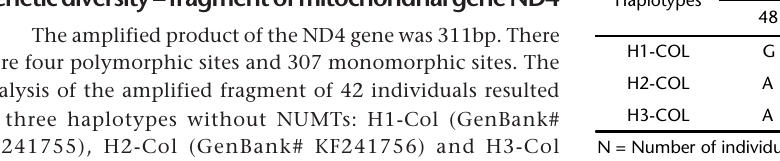
Table IV. Variable sites in three haplotypes of ND4 mitochondrial gene in Aedes aegypti from Colombia. Position of nucleotide Haplotypes